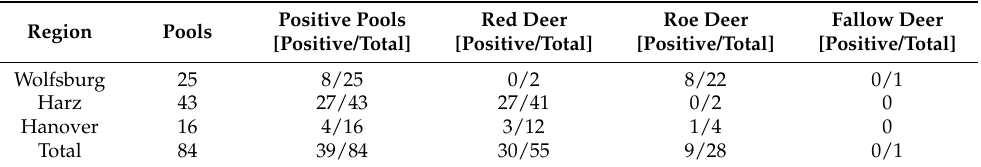
Table 2. Results of RT-qPCR tests for ALSV from wild game tick pools separated by sampling location and animal species (shown in positive pools/total